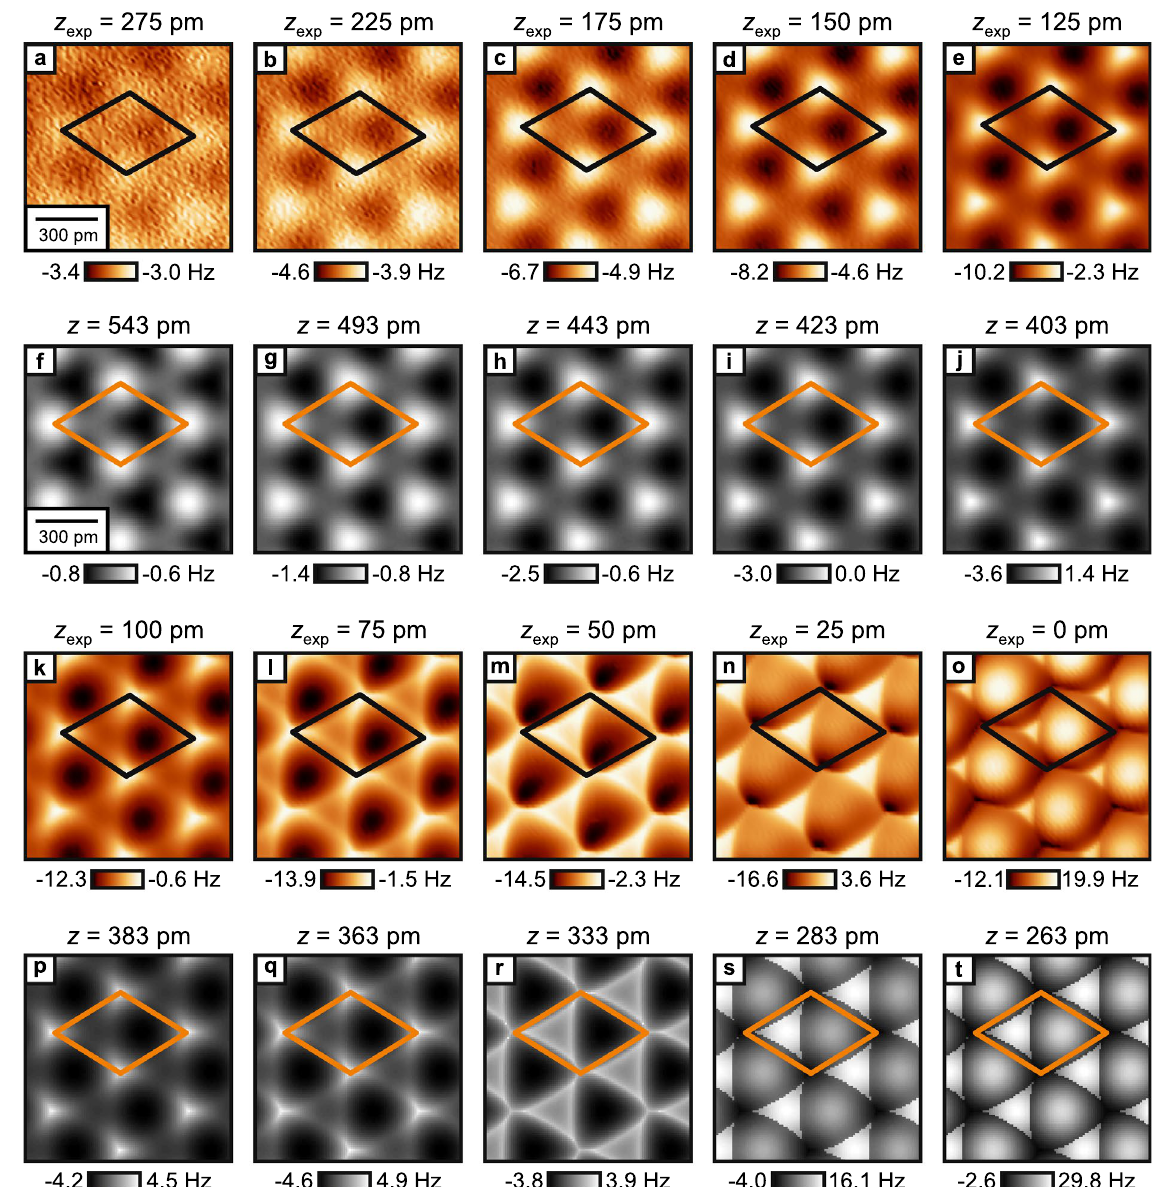
Figure 2. ( a – e , k – o ) Experimental constant-height (cid:31) f images as a function of tip-sample distance (raw data) measured with a CO tip on CaF 2 (111) at the same spot on the sample. z exp = 0pm is defined as the closest tip- sample approach in the experiment. ( f – j , p – t ) Constant-height images calculated with the probe particle model for a CO tip on CaF 2 (111) over a similar tip-sample distance range as the experimental images. The calculation − reproduces all measured contrast in good agreement. z is defined as the vertical distance between the F top and the tip apex oxygen nuclei. The unit cell defined in Fig. 1f is drawn in all − versus distance plots in Fig. 4e,f, showing that the contrast caused by Pauli repulsion above the F top ions (blue curve in Fig. 4e) is largest in magnitude. Having addressed the relevant physics at this tip-sample distance regime we can discuss the influence of CO bending on the AFM contrast. In the image recorded at the small- est tip-sample separation (Fig. 2o), the AFM contrast pattern resembles the hexagonal arrangement of bright spheres. This pattern would not be obtained by simply adding the three interactions obtained for a rigid probe − particle (Fig. 4a–c), which would yield a strongly repulsive feature above the surface F atoms (Fig. 4d). If the − probe particle is allowed to relax, it will slide around the exposed atoms of the surface F layer, which completely alters the observed AFM contrast. This mechanism leads to the above-mentioned appearance of bright, repulsive − sphere-like features at the positions of the Ca 2 + atoms and triangular features at the positions of the F bot atoms − in the AFM images. Above the surface F top atoms, CO bending causes the occurrence of sharp attractive ridges − (see Fig. 2o,t, the corners of the unit cells are at the F top positions).